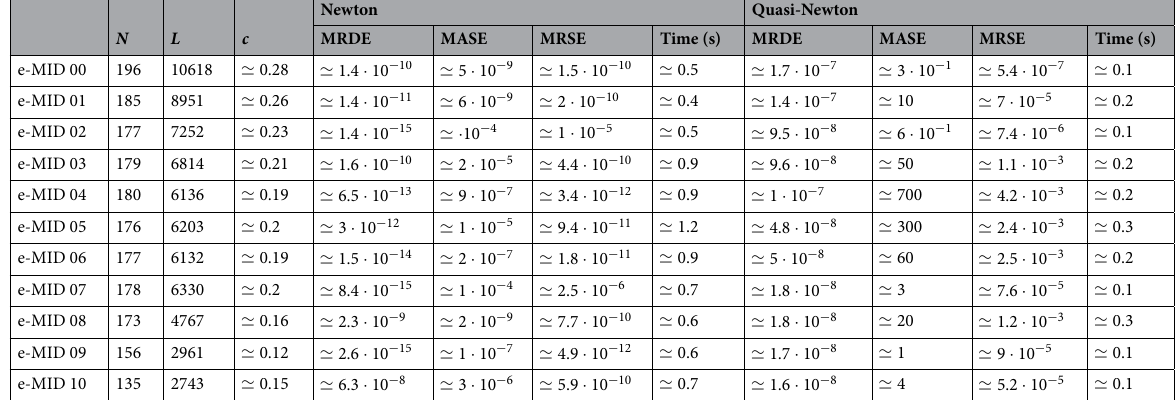
Table 5. Performance of Newton’s and the quasi-Newton method to solve the reduced system of equations defining the DECM, on a set of real-world WDNs (of which basic statistics as the total number of nodes, N , the L / N ( N 1 ) , are provided). While Newton’s method stops total number of links, L , and the connectance, c = − 8 L ( 10 θ) because the condition is satisfied, the quasi-Newton one always reaches the limit of 10000 2 − � ||∇ || ≤ steps. The results on accuracy and speed clearly indicate that Newton’s method outperforms the quasi-Newton one. Only the results corresponding to the best choice of initial conditions are reported. The results of the fixed-point recipe are not